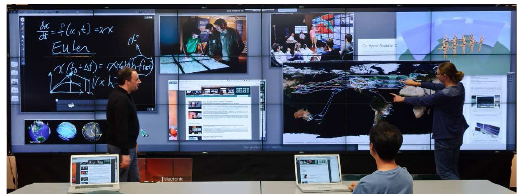
Figure 30. The EVL Cyber-Commons is shown fitted with a multi- user touch screen interface that enables multiple